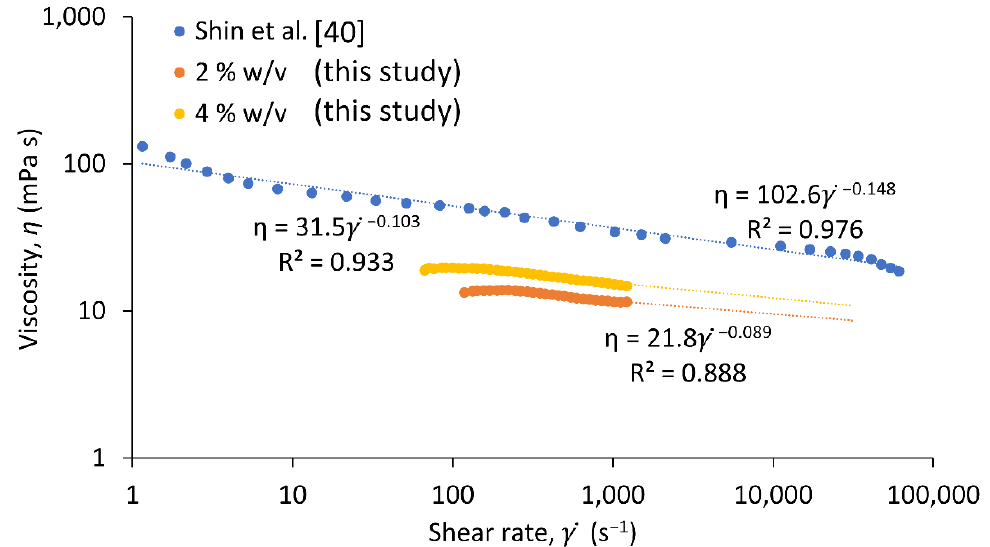
Figure 5. Comparison of viscosity vs. shear rate plots with published data for power law model determination at 2% w / v and 4% w / v starch concentration. Table 1. Power law parameters for starch at various